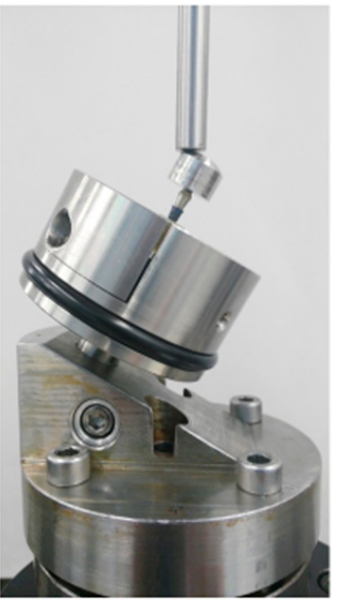
Figure 2. Clamp of the fatigue test machine.